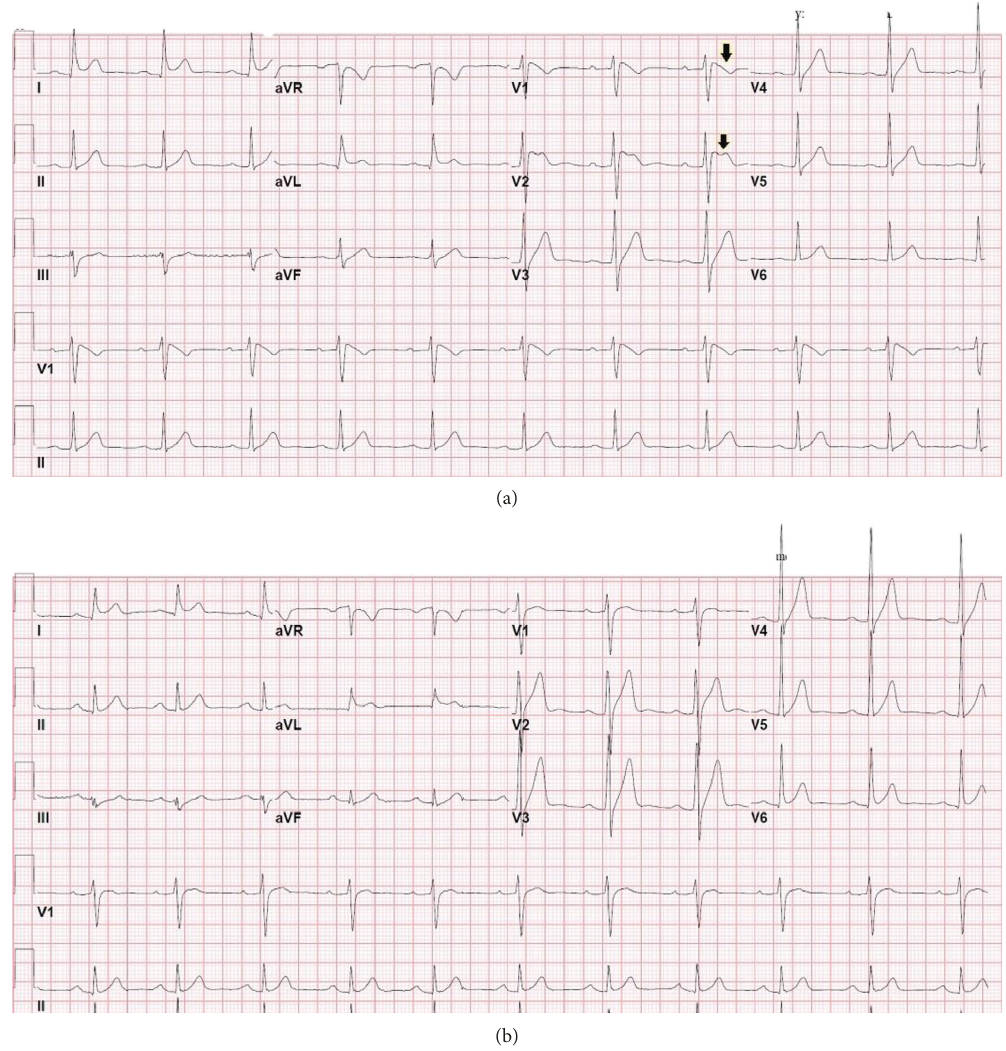
Figure 1: Electrocardiograms of the first admission revealing transient Brugada pattern (a, arrow) with complete resolution the following morning